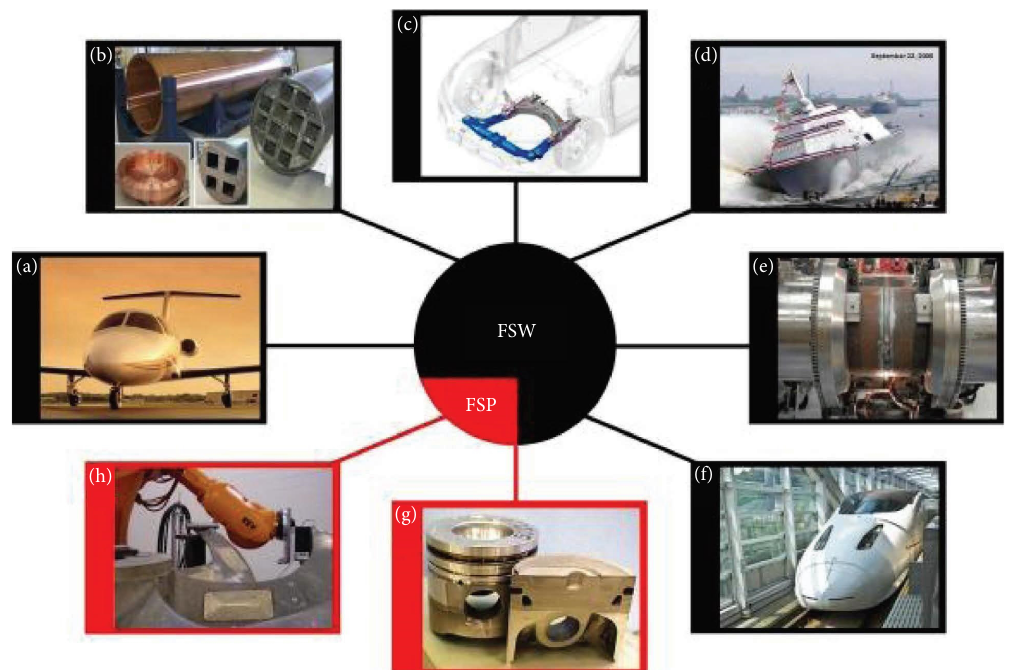
Figure 2: Product specifc applications of FSW [12]. (a) the eclipse 500 business jet, the frst to use FSW, (b) 50 mm thick copper nuclear waste storage canisters, (c) dissimilar FSW of aluminium to steel in Honda front subframe, (d) deckhouse structure of littoral combat ship, (e) orbital FSW of steel pipes, and (f) foor panels of Shinkansen